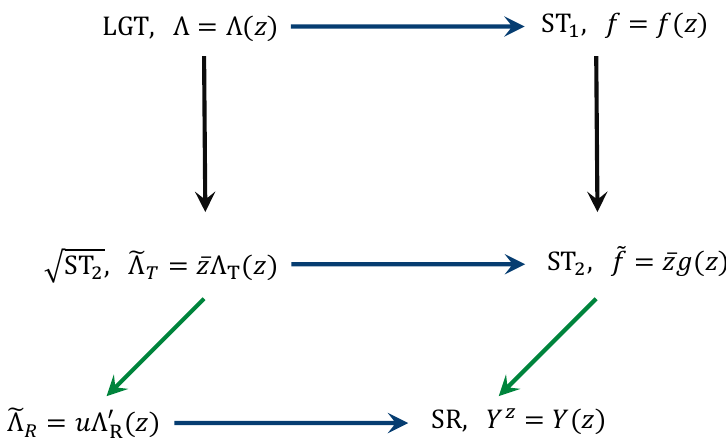
Figure 1 . Summary of the asymptotic symmetries and their various relations. LGT stands for non-abelian large gauge transformations, ST and SR for supertranslations and superrotations. Hor- izontal lines represent the DC relations. Vertical lines represent the symmetry raising map between the first and second family of symmetries. Diagonal arrows represent an increase in the power of r of symmetry parameters, see main text for